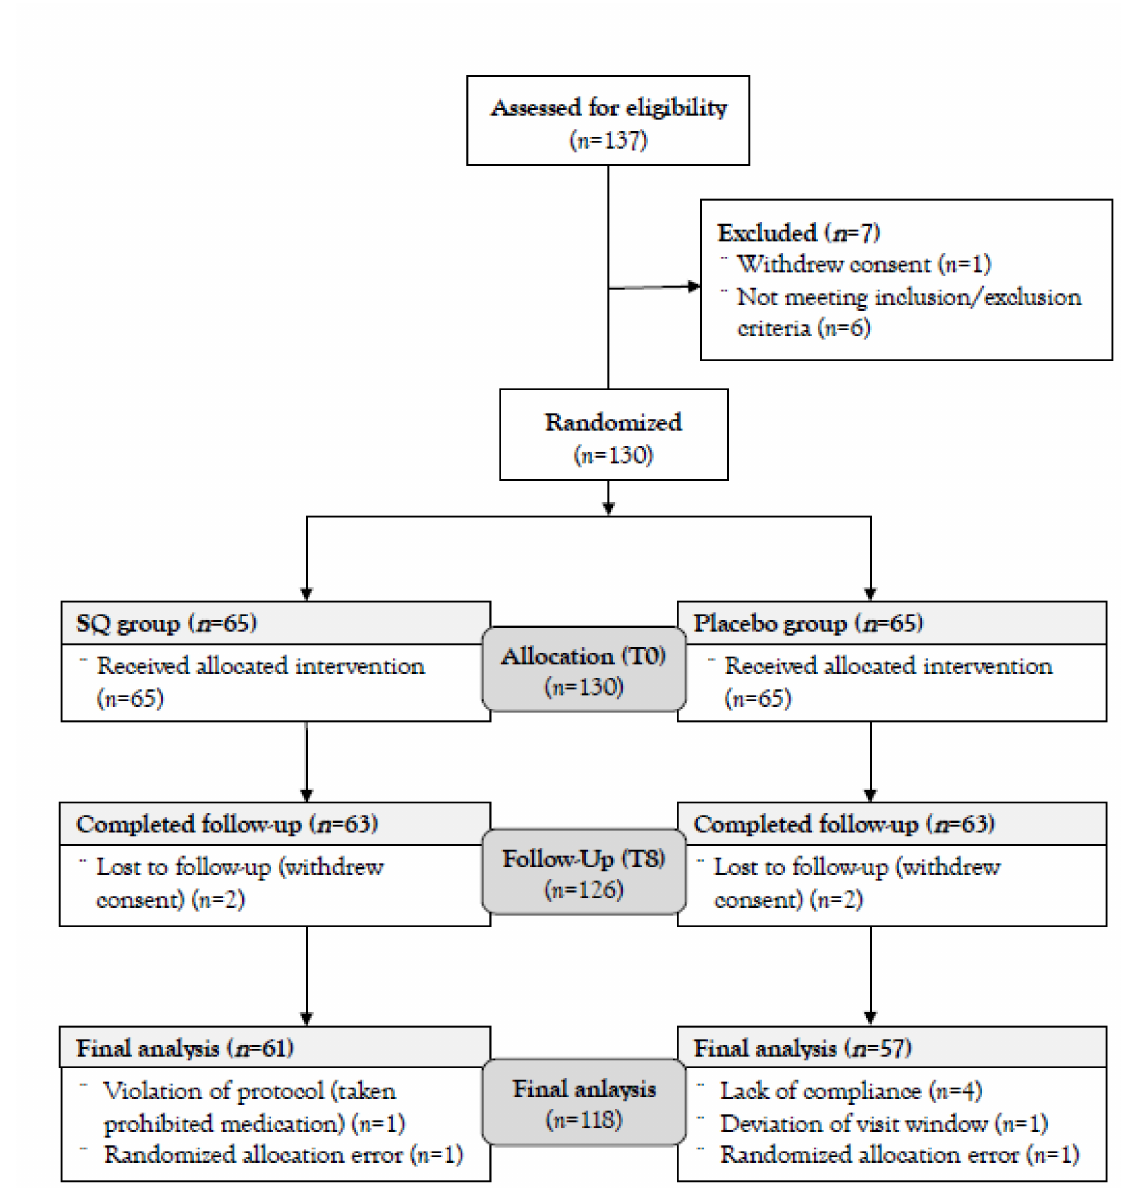
Figure 1. Flow diagram of the present intervention study: 137 subjects were screened before participating in the study, and a total of 130 subjects were finally enrolled. The subjects were randomly assigned to either the SQ or the placebo group at a ratio of 1:1. During the study period, 2 subjects in each group withdrew their study consent, and 2 and 6 subjects were excluded from the SQ and the placebo groups respectively, for the final analysis. Finally, a total of 118 subjects (SQ group: n = 61, placebo group: n = 57) were included in the final analysis. SQ: Sil-Q1. T0: baseline. T8: